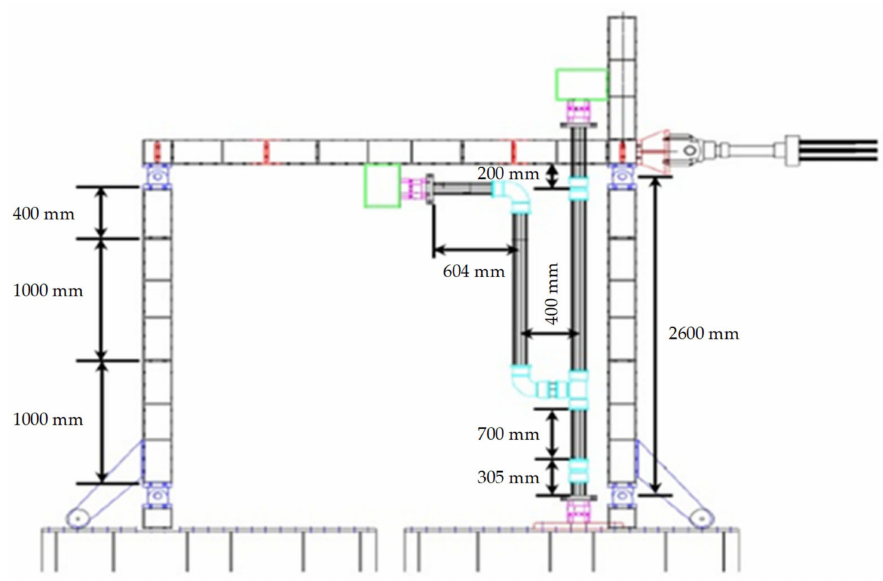
Figure 7. Schematic design of large-scale press-to-connect piping